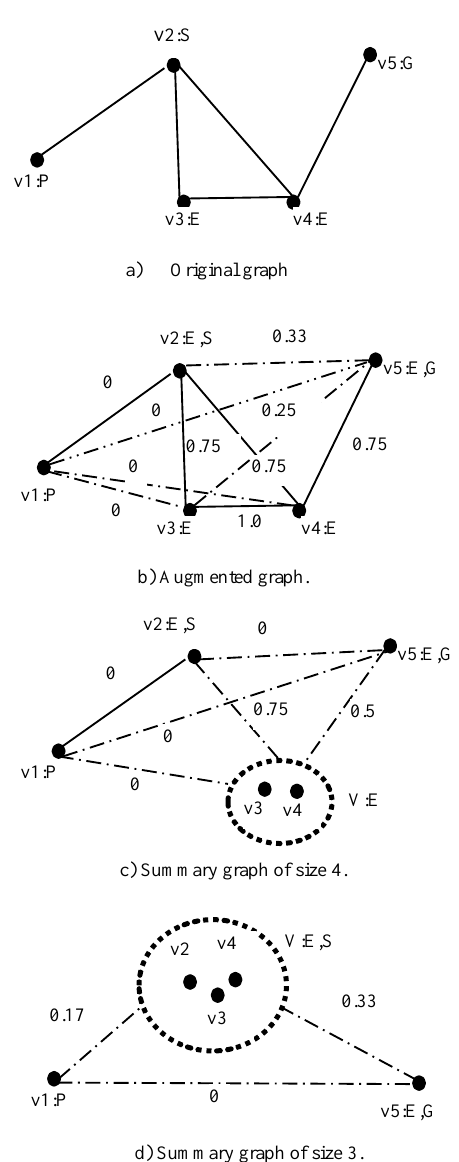
Figure 1. Proposed method demonstration by example. Main steps of method are depicted by Figures in 1(b), 1(c), and 1(d) for the graph of Figure